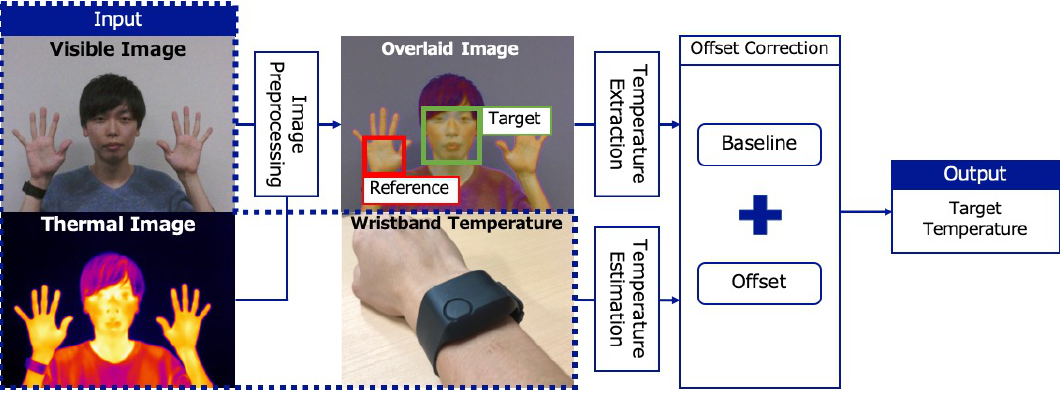
Figure 1. Overview of the offset correction.